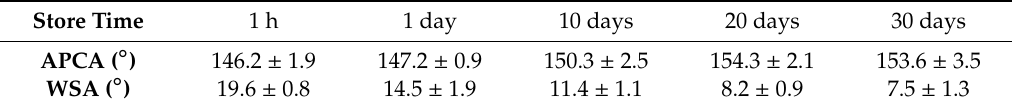
Figure 4. ( a ) Apparent contact angle (APCA) of laser ablation surface; ( b ) water sliding angle (WSA) of laser ablation surface. Table 2. Evolution of apparent contact angle (APCA) and water sliding angle (WSA) measurements (°) with storage time.